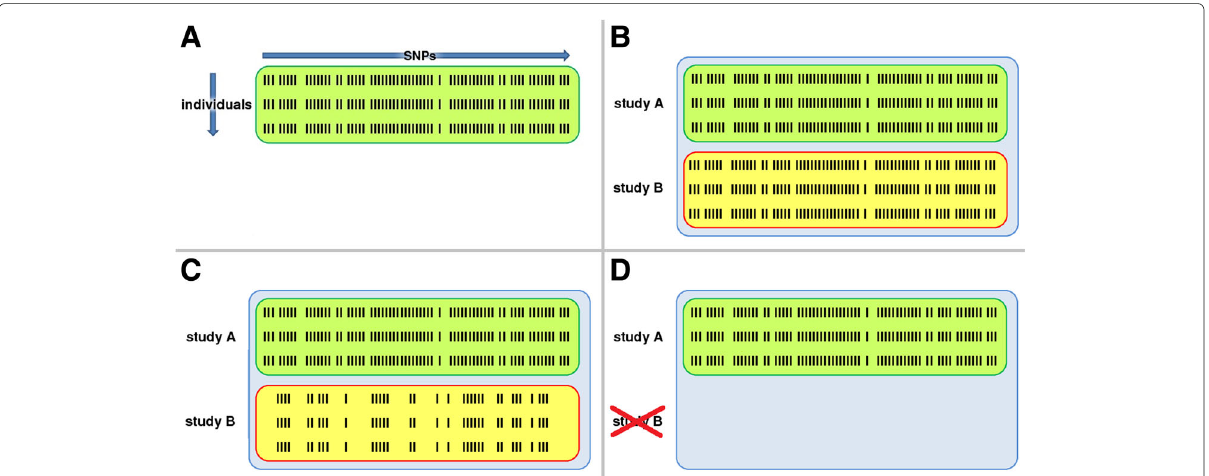
Fig. 1 Scenarios appearing in the analysis of consortial data based on two studies after imputation. a . Illustration of SNP data for all individuals in a study. Every row contains all SNP data for one individual and each column represents the data for one SNP and all individuals. b . A perfect world: Both studies cover the same SNPs for all individuals ( full ). c . Reality: Differential coverage of SNPs in both studies. All SNPs in study B are a real subset of the SNPs in study A. An ideal analysis can use all applicable information (indicated by red for reduced). d . Reality: Differential coverage of SNPs in both studies as in Fig. 1c. In a complete case analysis, all information from study B is dropped (indicated by part for